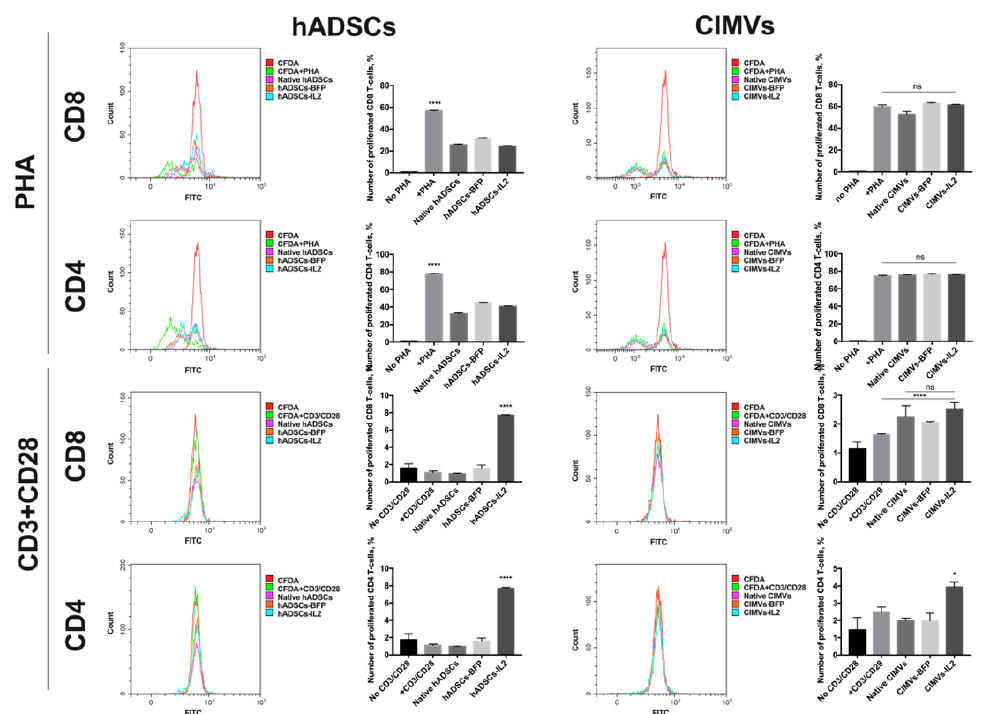
Figure 7. In order to evaluate the effect of hADSCs and CIMVs on the proliferative activity of T-cells, the proliferation of PBMCs isolated from peripheral blood was stimulated using PHA or a CD3 + CD28 antibody complex to mimic antigen presentation. Analysis of PHA-stimulated T-cell proliferation after co-culture with hADSCs showed that co-cultivation with hADSCs had a significant suppressive effect on the proliferation of CD4 + and CD8 + T-cells. Whilst the proliferation of PHA-stimulated CD4 + and CD8 + T-cells remained unchanged after co-culture with CIMVs. After stimulation with CD3 + CD28 antibodies, an increase in the number of CD4 + and CD8 + T-cells was detected in the PBMCs after cultivation with hADSCs-IL2, while after cultivation with CIMVs-IL2, the number of CD4 + T-cells slightly increased, and the number of CD8 + T-cells remained unchanged. Each histogram represents the fluorescence of PBMCs after cultivation with hADSCs or CIMVs, where the weaker the fluorescence intensity in comparison with control culture (designated as CFDA), the higher the proliferative activity. Each graph represents the number of proliferating cells which was calculated in reference to negative control. The negative control, in which PBMCs remained unstimulated (no PHA or CD3+CD28 was added), was used to define the threshold of CFDA signal for non-proliferating T-cells. The number of cells with lower CFDA per cell (as compared to the negative control) was accepted as the number of proliferating cells. Each box represents the mean ± SD ( n = 4) of four biological replicates. * p < 0.05, **** p < 0.0001. With the CD3 and CD28 antibodies, PBMC proliferation was significantly lower com- pared to PHA. The addition of CD3 + CD28 did not lead to a significant increase in the proliferation of CD4 + T-cells, neither when T-cells were cultured alone (1.15 ± 0.13%), nor